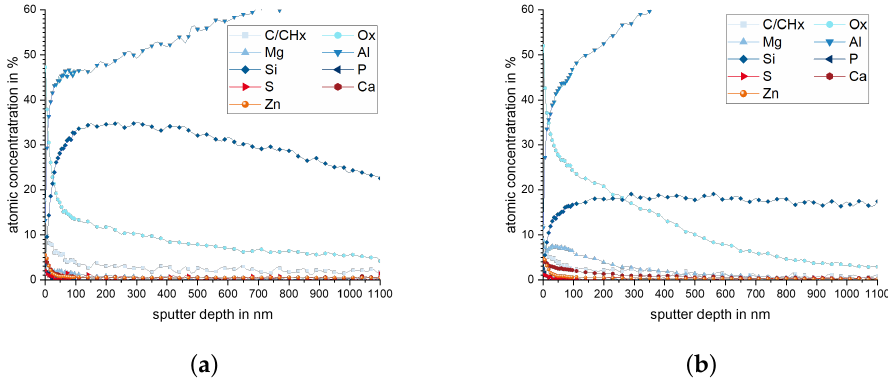
Figure 10. Chemical composition of elements with more than 2% atomic concentration (measured by XPS) of 10.4% Si pin surfaces after wear tests in ( a ) as-cast state and ( b ) FS state. The content in Si and Mg in the subsurface material of pins from 10.4% and 14.6% Si after wear testing is presented in Figure 11. A rise in the Si content is observed for